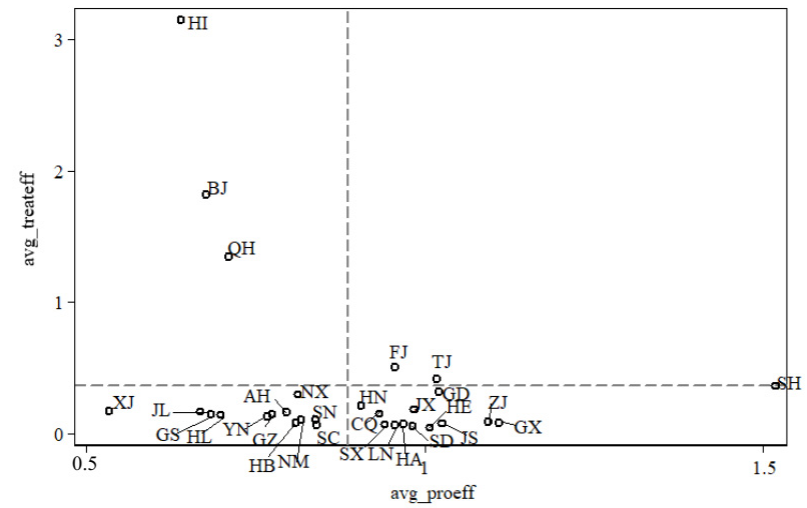
Figure 8. Two-dimensional graph of China’s provincial eco-efficiency distribution. (Source: Authors compiled). Note: The horizontal axis represents the production efficiency on average, and the vertical axis represents environmental treatment efficiency on average.